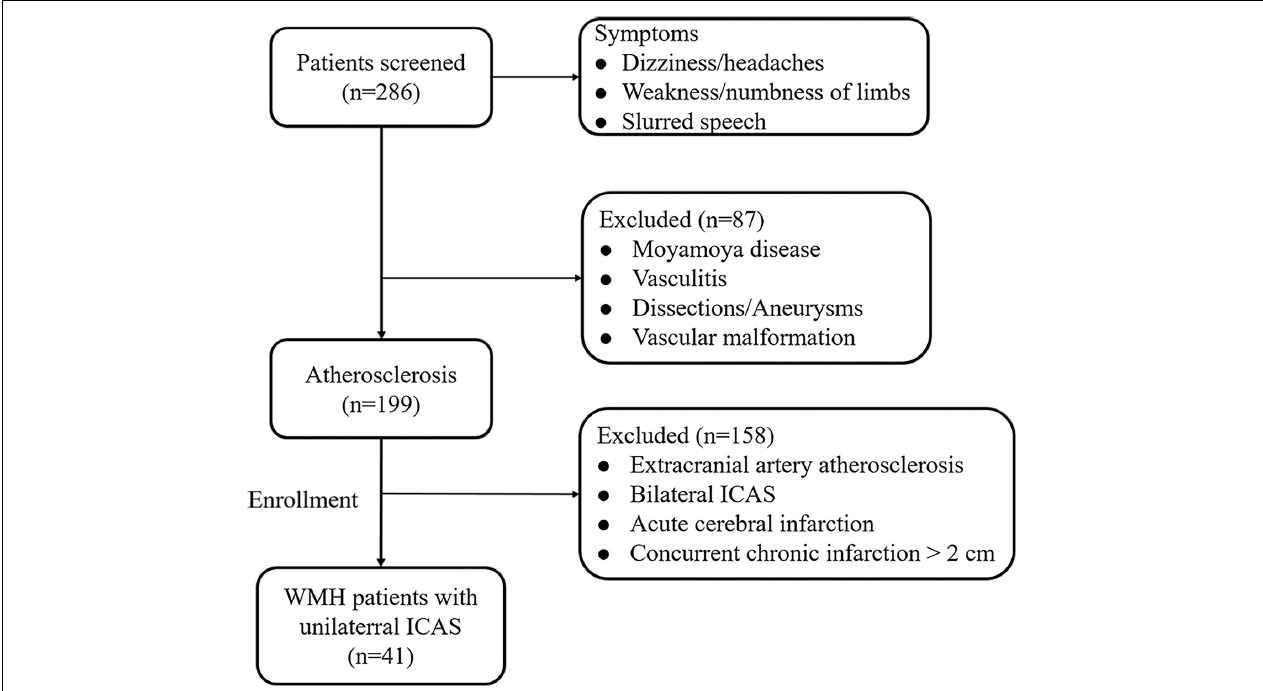
FIGURE 1 | Flowchart for patient